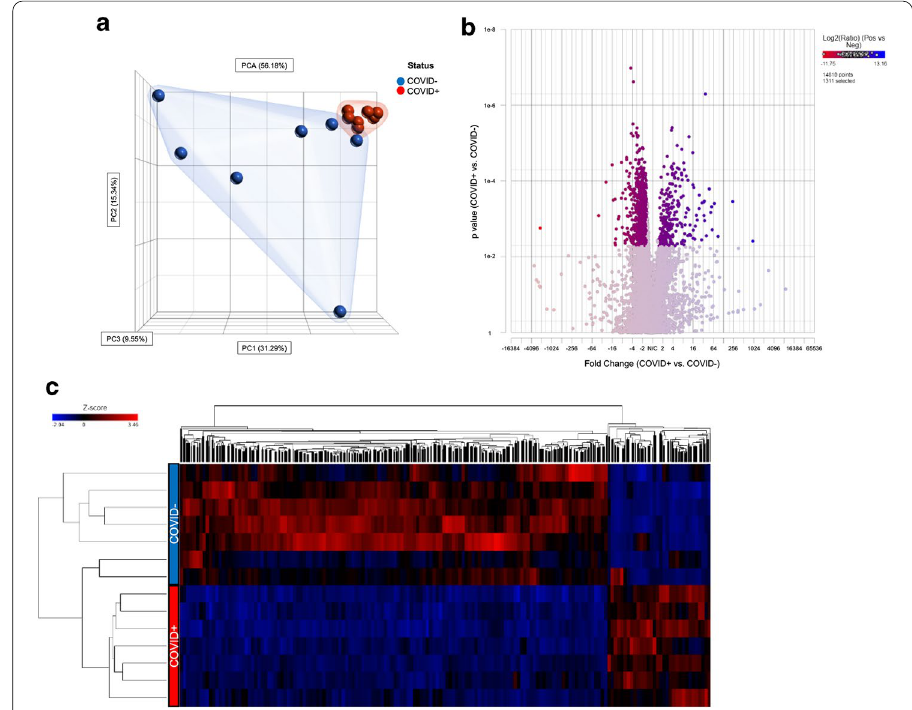
Fig. 1 Leukocytes from COVID19 ICU patients have a unique transcriptional profile compared to + leukocytes from COVID19- ICU patients. a Principal component analysis (PCA) plot of total leucocyte (buffy coat) RNA samples derived from COVID19-positive (COVID ) and negative (COVID ) patients after removing + − the batch effect of date and interaction between date and status, using all principal components and features contributing equally. b Volcano plot of 1311 genes (highlighted) differentially expressed between leucocyte RNA samples derived from COVID19 positive (COVID ) versus negative (COVID ) samples + − based on a filtering criterion of 1.5-Fold change and an FDR step-up p -value cut-off 0.0545. c Heat map ± ≤ of 1311 genes that were differentially expressed between leucocyte RNA samples derived from COVID19 positive (COVID ) versus negative (COVID ) samples using average linkage, Euclidean distance metric and + − standardize normalization mode (shift mean to 0 and scale standard deviation to 1 on all